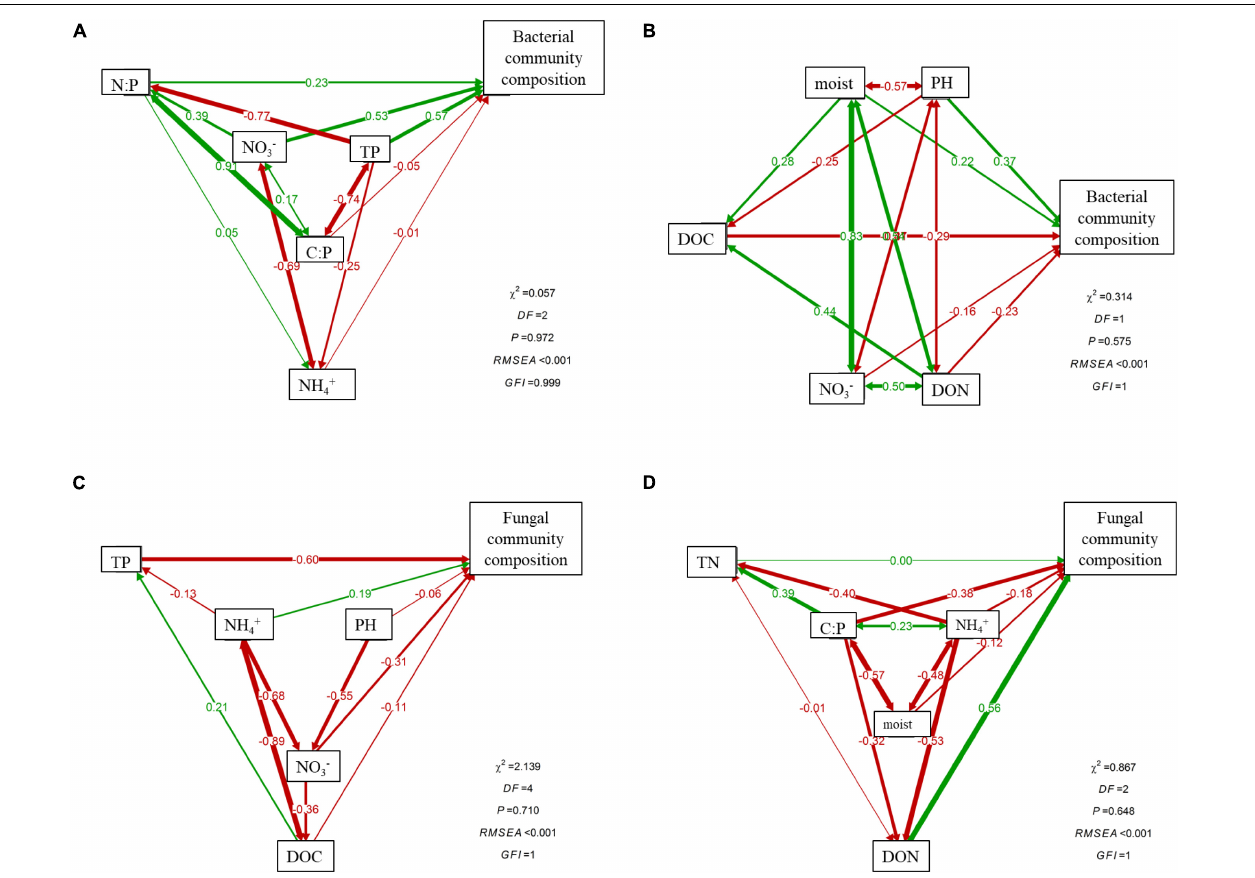
FIGURE 6 | Structural equation models showing the contributions of soil properties on rhizosphere and bulk soil bacterial (A,B) and fungal (C,D) community composition. Numbers on arrows are standardized path coefficients. Arrow thickness represents the magnitude of the path coefficient. Red solid lines indicate that the standardized regression weights are negative; green solid lines indicate that the standardized regression weights are